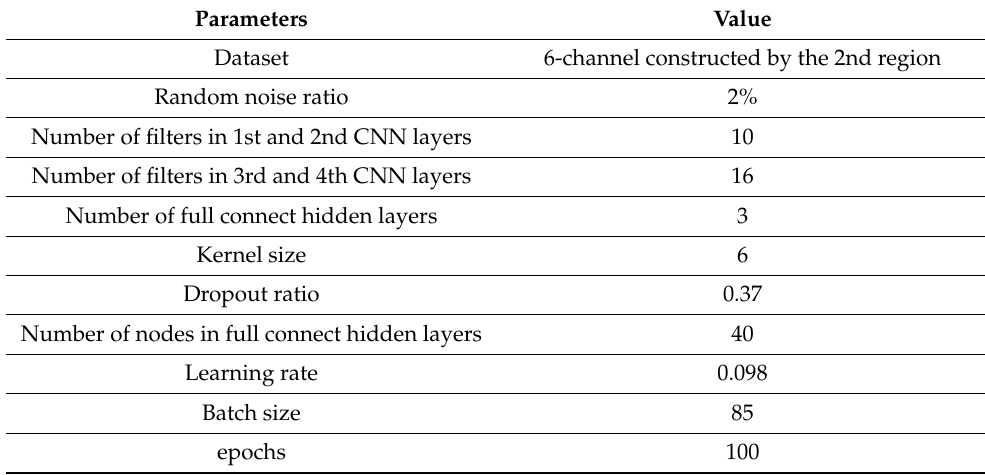
Table 6. Dataset, hyperarameters and noise ratio configuration of the best model. Parameters Value Dataset 6-channel constructed by the 2nd region Random noise